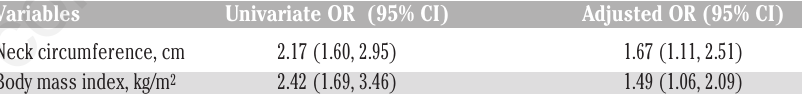
Table 2. Factors associated with having obstructive sleep apnea-induced hypertension by multiple logistic regression analysis.